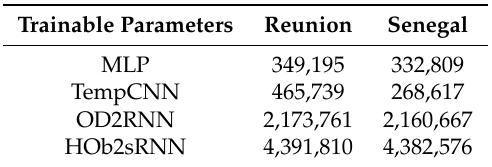
Table 3. Trainable parameters of neural network approaches i.e., MLP, TempCNN, OD2RNN, and HOb2sRNN on both study